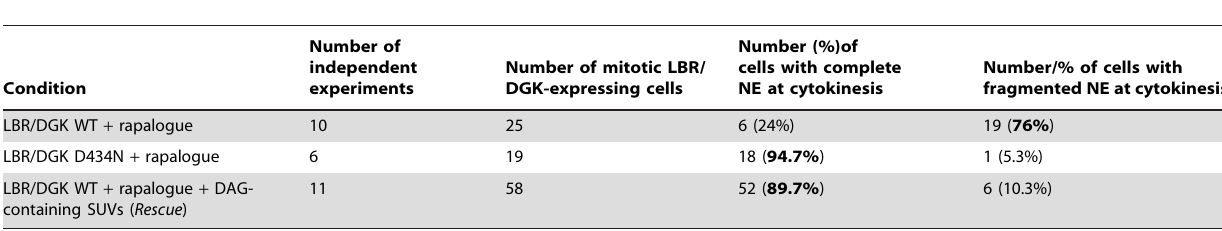
Table 1. Quantification of NE phenotype in single cell experiments of HeLa cells co-expressing LBR and DGK e .